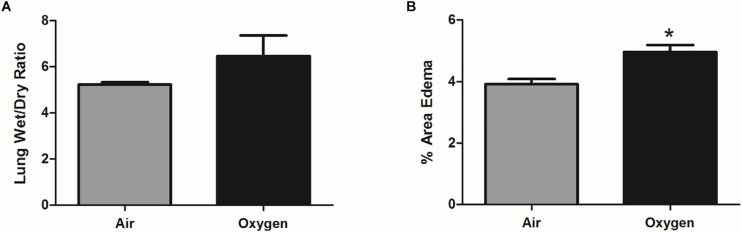
Assessment of pulmonary edema in air control group (gray bar) and oxygen group (black bar). (A) Pulmonary edema, quantified by lung wet-dry ratio, showed an increased trend (p = 0.07, student’s t-test) in the oxygen group when compared to the air control group. Bars represent mean wet-dry ratio ± SEM. (B) On direct histological quantification the percent area of interstitial edema was significantly increased in the oxygen group when compared to the air control group. Bars represent mean percent area edema ± SEM. Asterisk represents significance (p = 0.0003) as determined by student’s t-test.